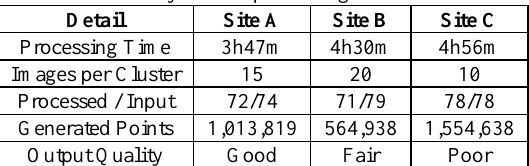
Table 6. Summary of PPT processing for all of the sites Detail